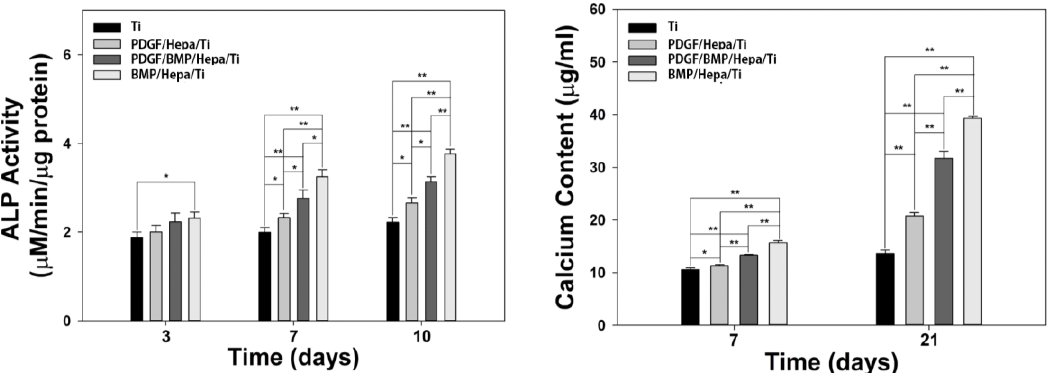
Figure 5. ( a ) Alkaline phosphatase (ALP) activities of cells cultured on Ti, PDGF/Hepa/Ti, BMP/Hepa/Ti, and PDGF/BMP/Hepa/Ti for 3, 7, or 10 days (* p < 0.05 and ** p < 0.01); ( b ) Calcium contents of cells grown on Ti, PDGF/Hepa/Ti, BMP/Hepa/Ti, and PDGF/BMP/Hepa/Ti for 7 or 21 days (* p < 0.05 and ** p < 0.01).